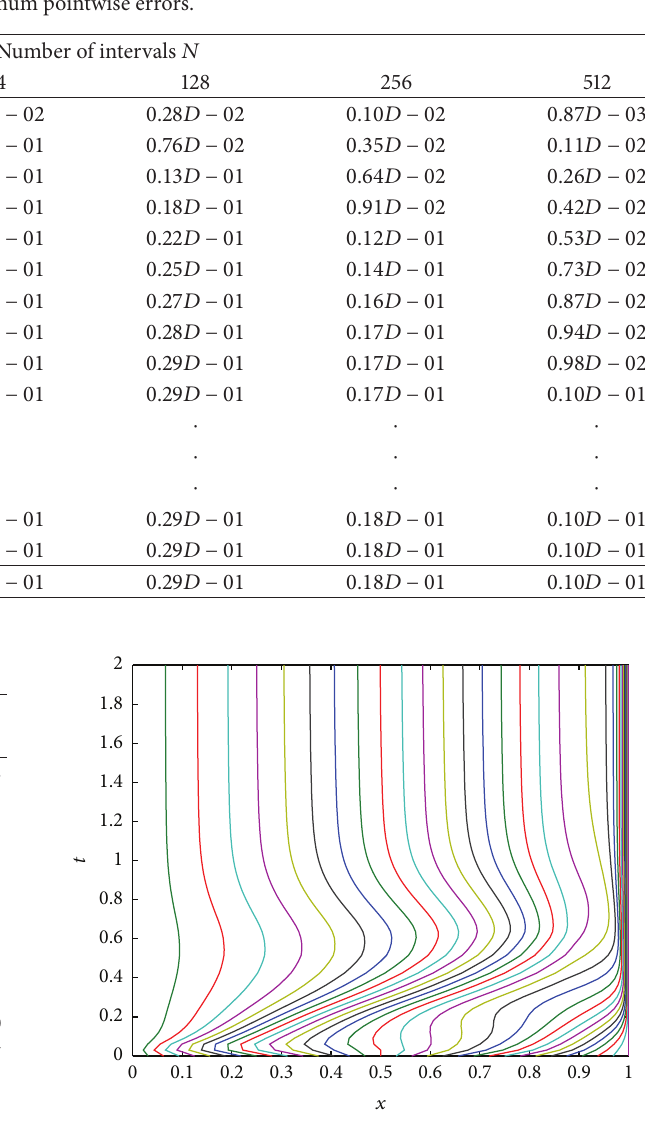
Figure 3: Mesh trajectory with 𝜀 = 2 −6 , 𝜏 = 0.05 , and 𝑁 = 32 .